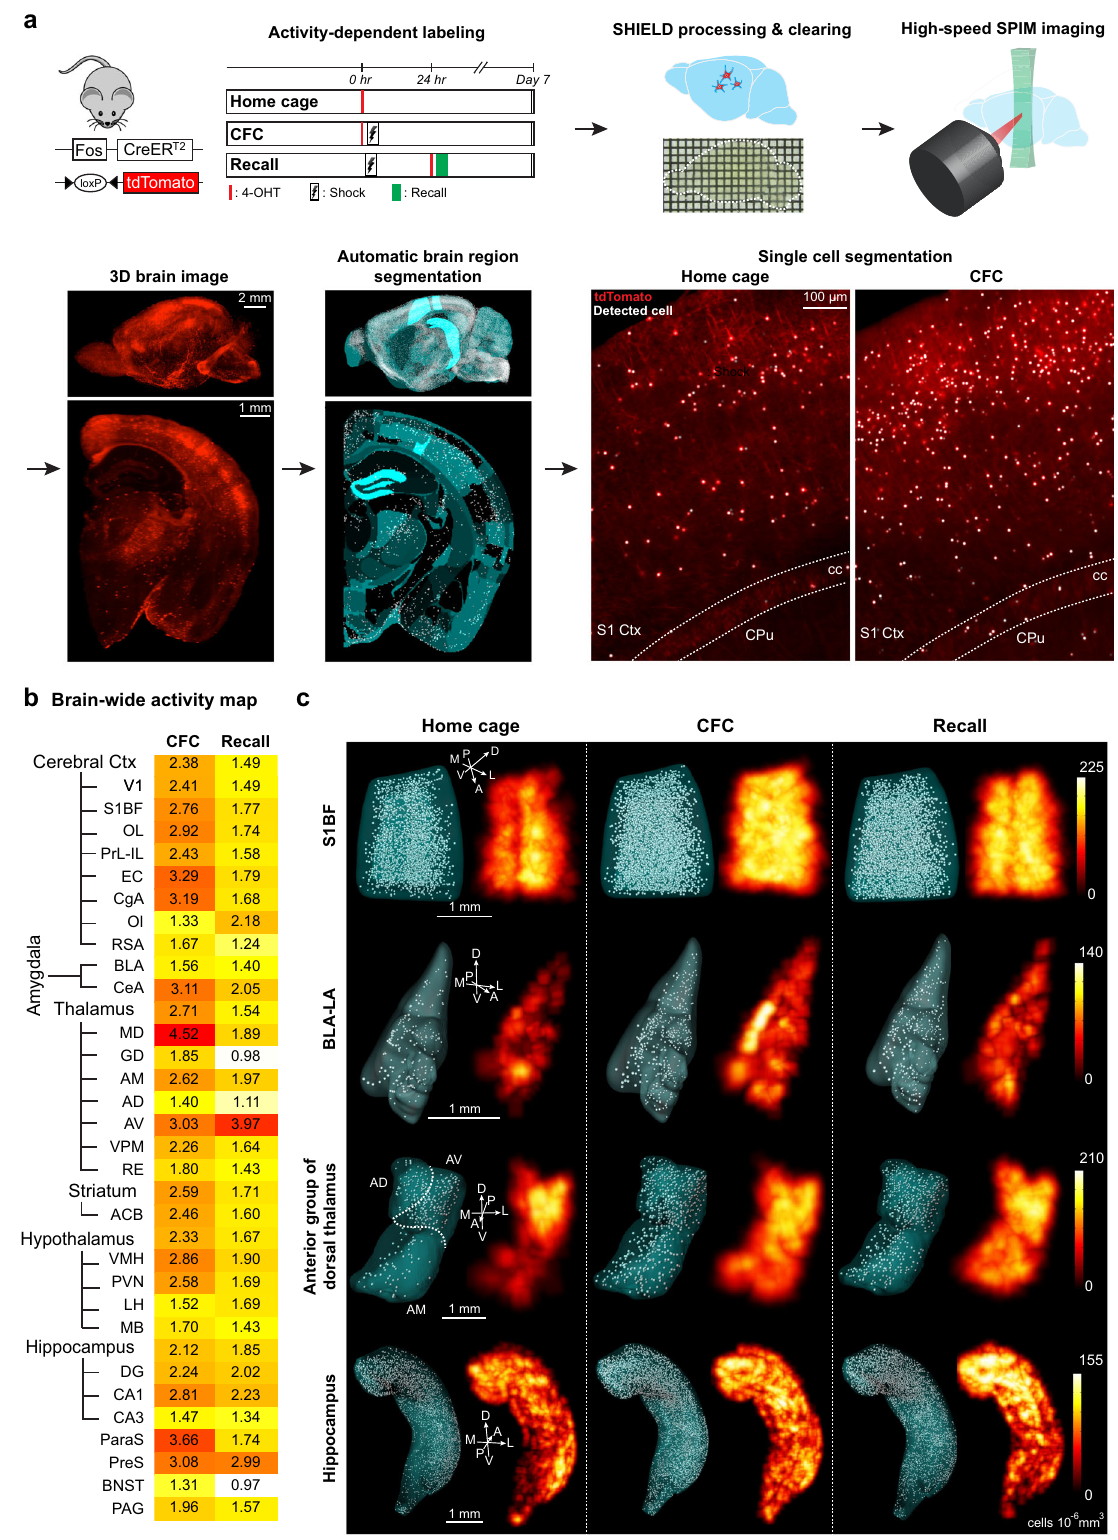
neurons were strongly activated by both encoding and recall, but their role in memory formation has previously been less under- stood as compared to hippocampal and amygdala subregions (Fig. 1b). These regions include thalamic structures, namely the anteromedial thalamus (AM) sub-division of the anterior group of dorsal thalamus, MD, and nucleus reuniens thalamus (RE),